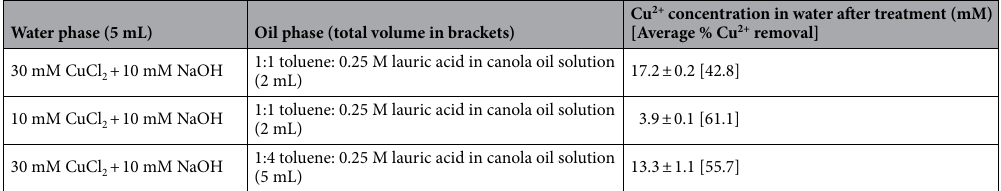
Table 7. ICP analyses of the water phase of samples prepared starting with 30 mM CuCl 2 and 10 mM CuCl 2 , using toluene and lauric acid solutions in canola oil. The volumes used and the lauric acid concentrations are as indicated in the table. Partitioning of copper ions in the toluene phase with lauric acid and a base is also achieved without using canola oil, as qualitatively assessed based on the discoloration of the toluene phase (Fig. S13, supporting information). Measurements were done after 24 h equilibration.